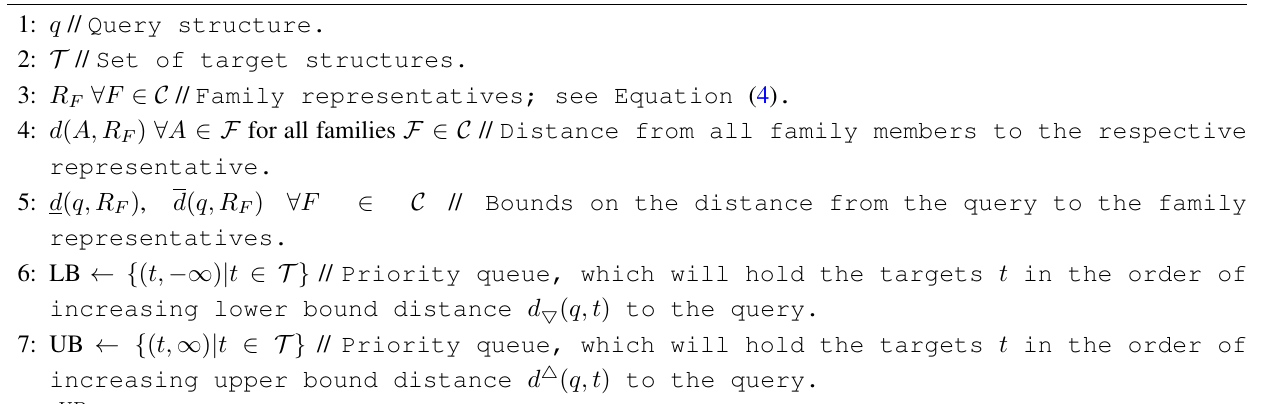
Algorithm 1 Solving the k -NN classification